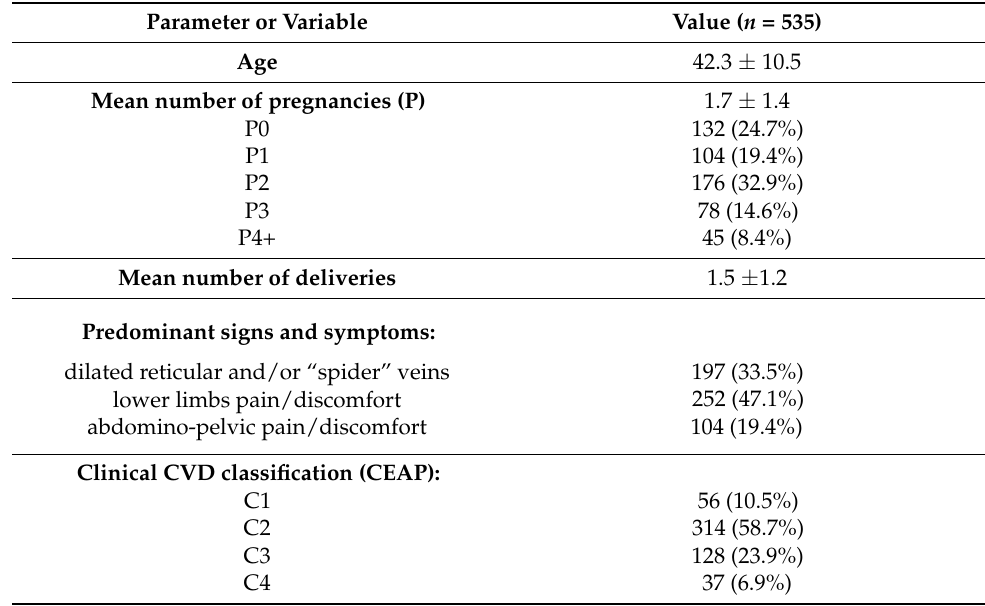
Table 1. Characteristics of assessed group. The values shown in table represent mean ± SD, or the number (%) of patients reporting evaluated symptom (or feature) in the group, respectively.